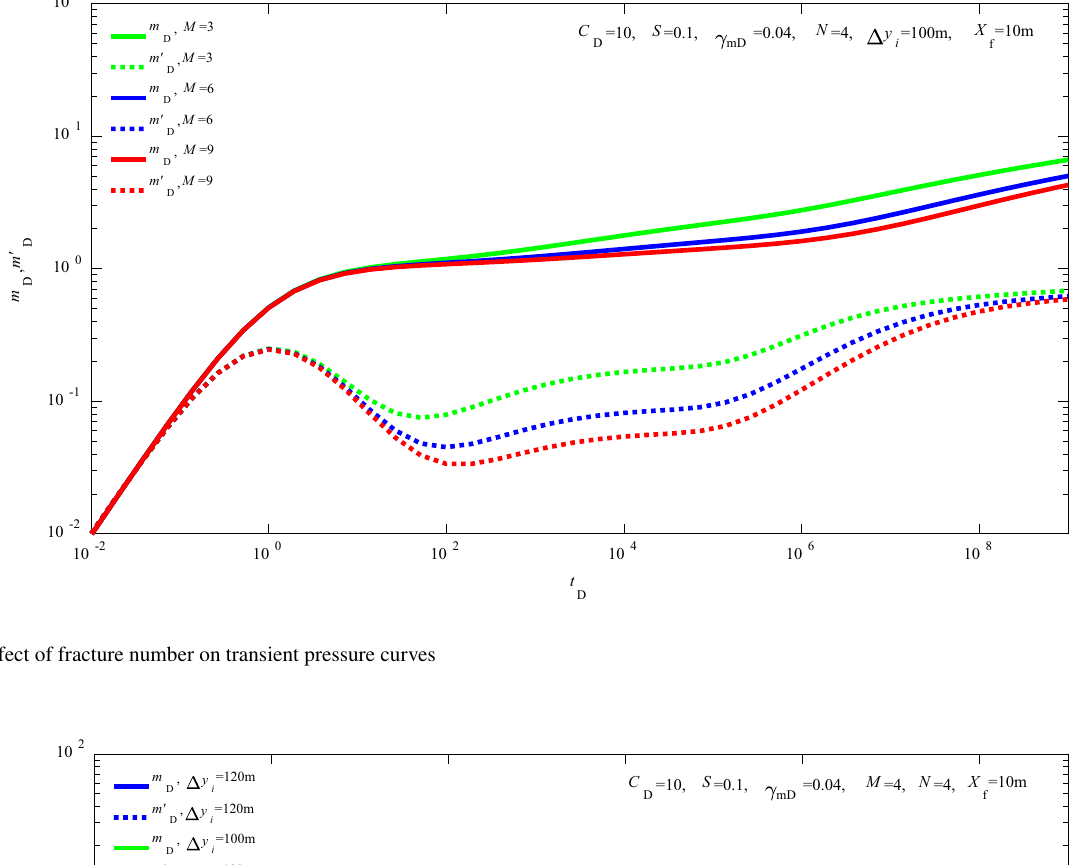
Fig. 5 Effect of fracture number on transient pressure curves